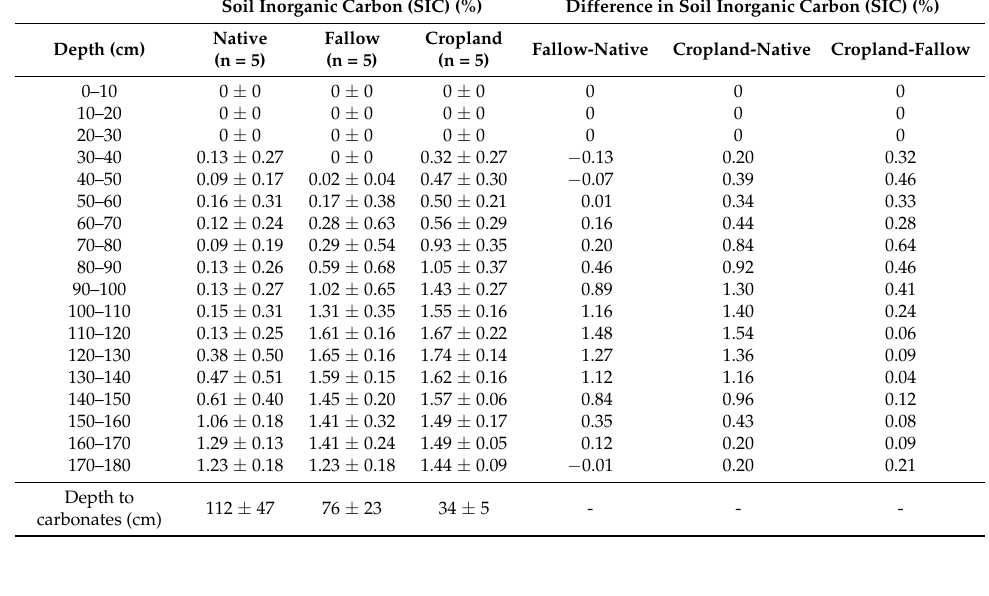
Table 8. Soil inorganic carbon (mean ± standard deviation) distribution with depth.